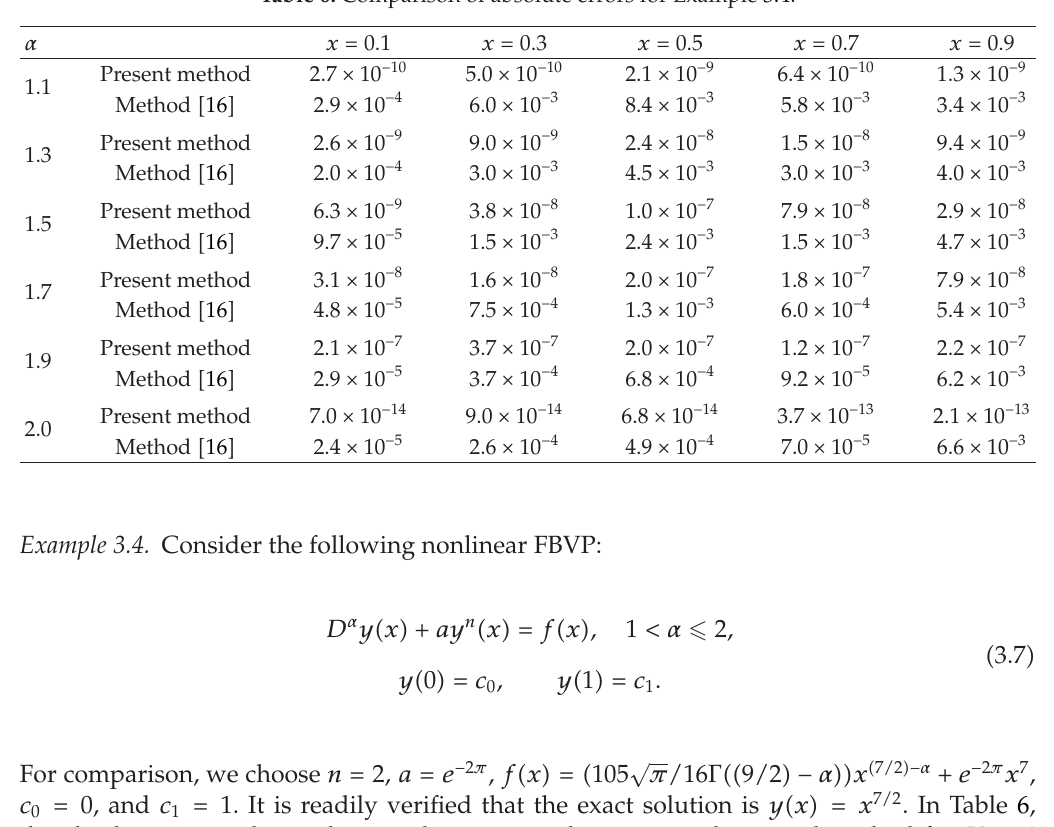
Table 6: Comparison of absolute errors for Example